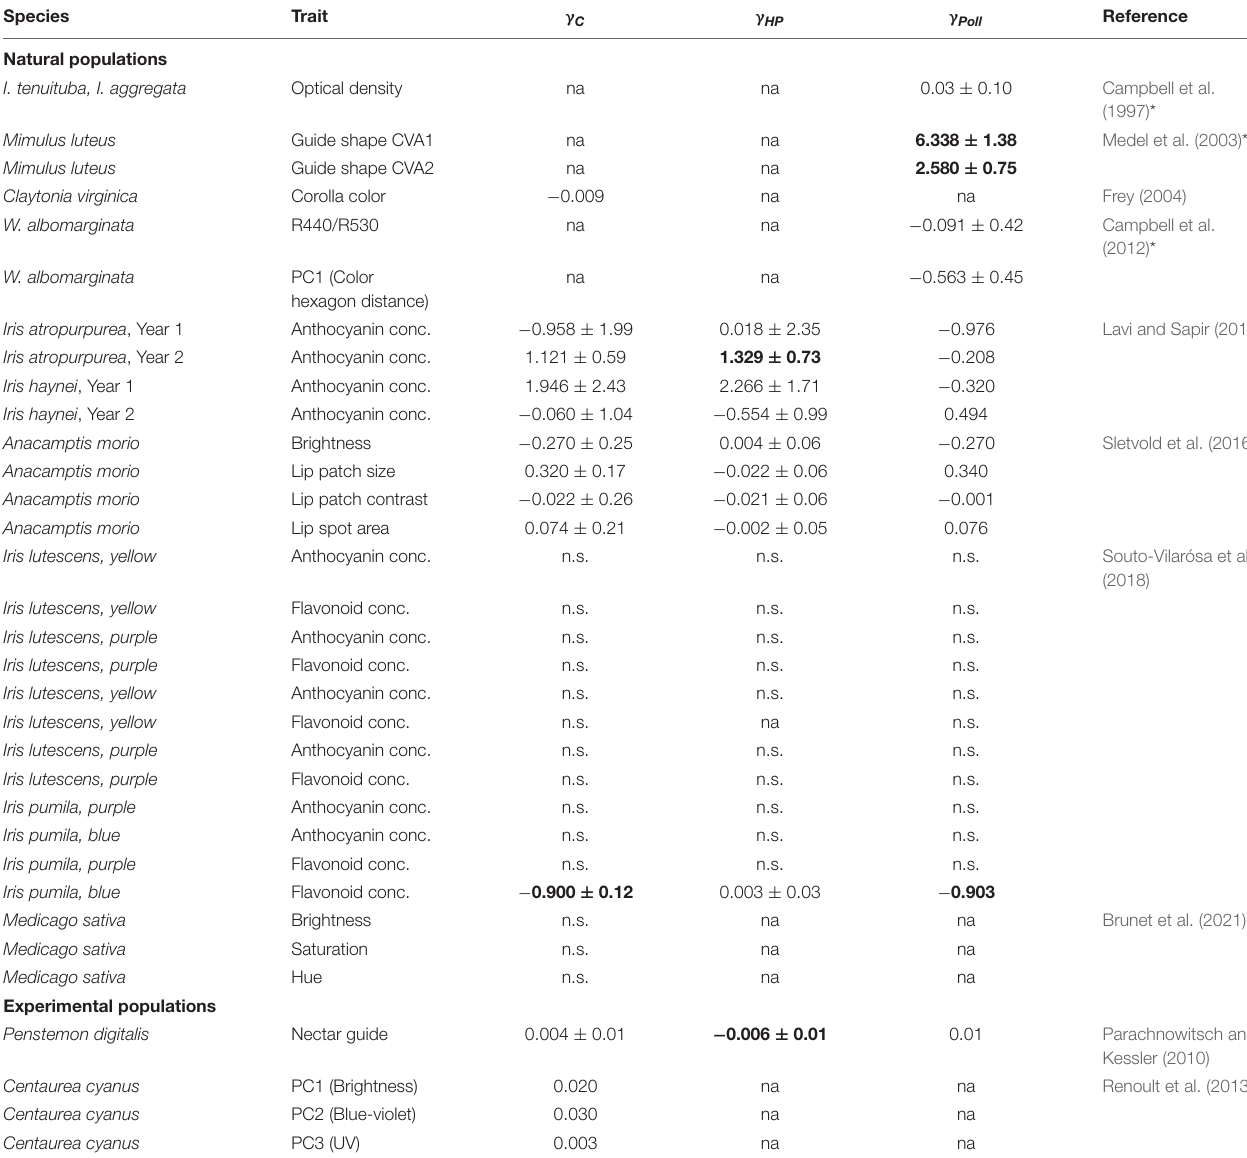
TABLE 3 | Summary of quadratic selection gradients ( ± SE) extracted from the literature for net selection ( γ C ), non-pollinator-mediated selection ( γ HP ) and pollinator-mediated selection ((cid:49) γ Poll ) on flower color estimated in natural plant populations and experimental